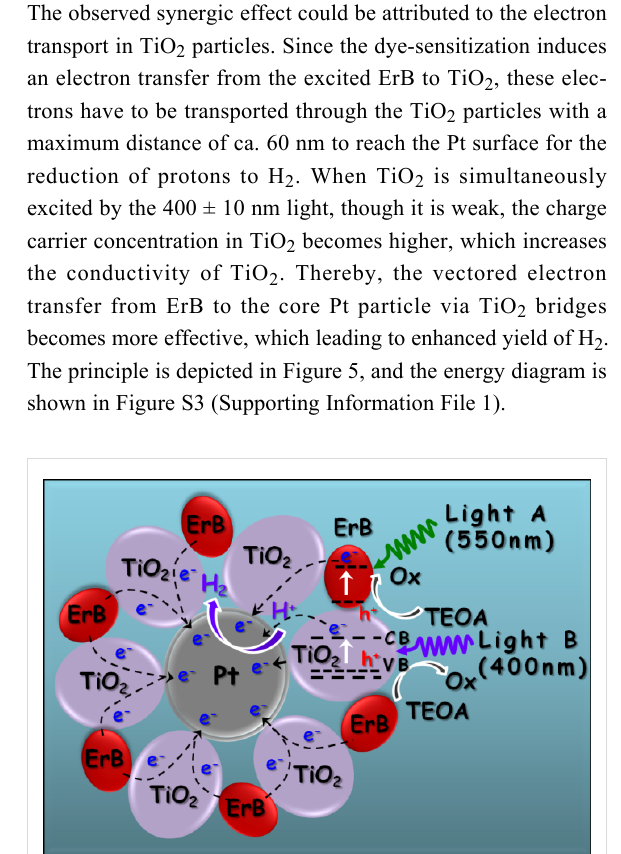
Figure 5: Schematic illustration of the photocatalytic H 2 generation by ErB-sensitized Pt@TiO 2 core–shell nanostructures under irradiation of light A (550 ± 20 nm) and/or light B (400 ± 10